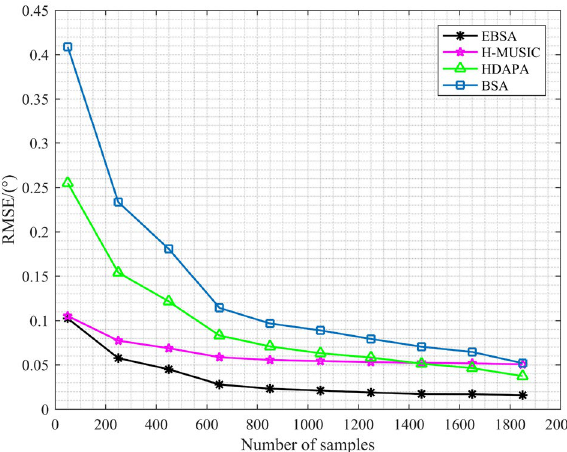
Figure 5. RMSE curves with different number of